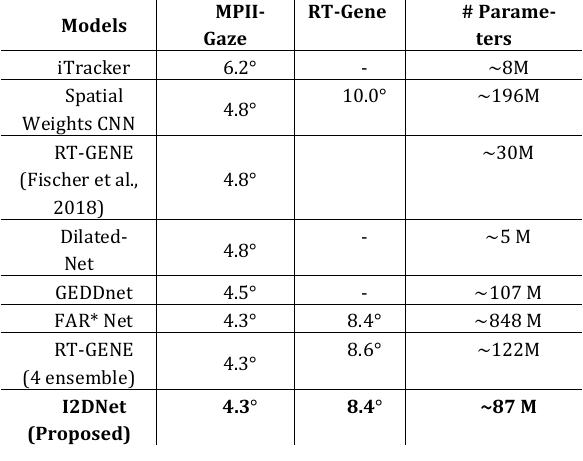
Table 1: Mean Angular Errors for Gaze Estimation Models